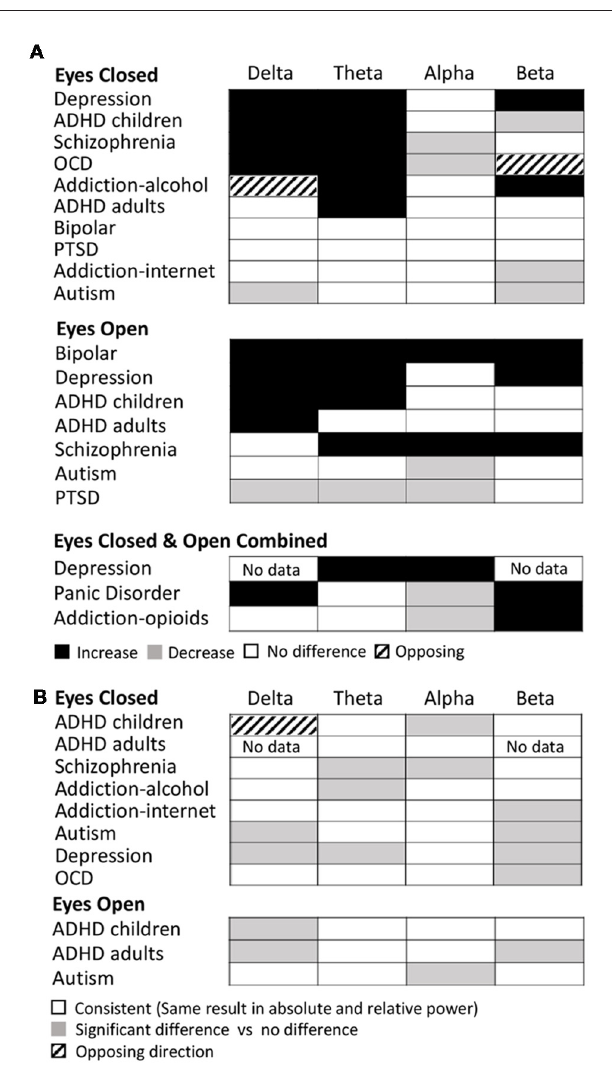
FIGURE 3 | Dominant results for each individual disorder and band. (A) Differences in absolute power for each disorder (relative to control) for eyes closed condition (top), eyes open (middle) and eyes open and closed combined (bottom). White boxes indicate no change, black indicates an increase, and gray indicates a decrease. Opposing results are shown by hashed boxes. (B) Difference in results between absolute power and relative power for the same disorders. White indicates no difference, gray indicates a significant increase or decrease in one but no significant difference in the other, while a hashed box indicates opposite